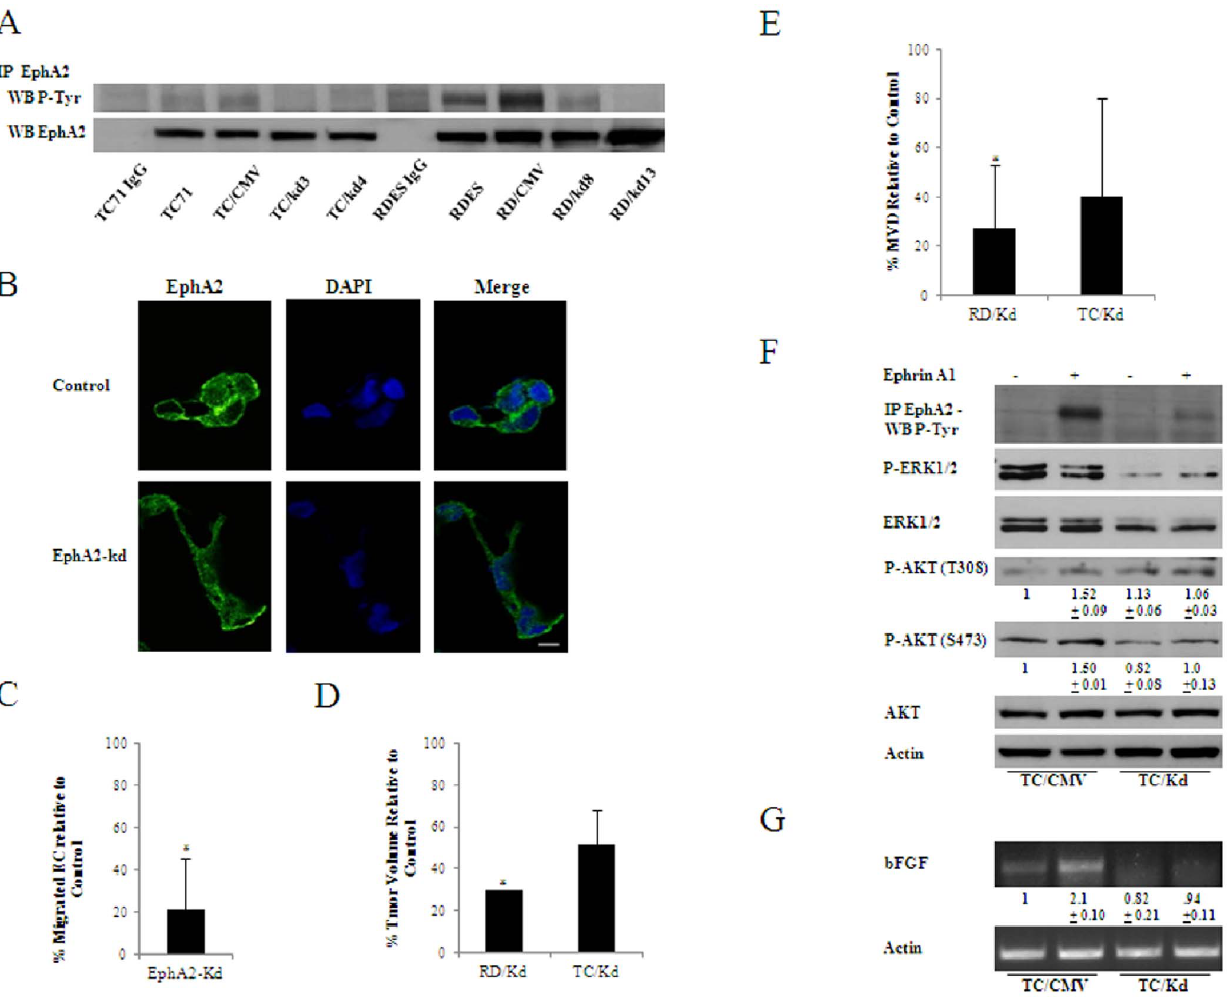
Figure 7. Dominant negative EphA2 recapitulates CAV1 silencing effects on angiogenesis. A. Phosphotyrosine immunoblot confirming the dominant negative effects of EphA2-Kd vector in RDES and TC71 cells (RD/CMV and TC/CMV states for empty-vector transfected cells). EphA2 blotting was used as control. B. Immunofluorescence of EphA2 showing redistribution in cell cytoplasm as a consequence of EphA2-Kd transfection. Scale bar, 10 m m. C. Quantification of transwell cell migration, CM from the EphA2-Kd models was used as chemoattractant for endothelial cells; bars, SD (*P # 0.05 n=3); vertical bars represent mean percentage of migrated endothelial cells relative to control. D. Mice xenograft volumes comparing tumors of 2 EphA2-Kd cell clones (n=5 for each clone) relative to grouped controls (parental n=5; empty vector n=5); vertical bars represent mean percentage of tumor volumes relative to controls; bars, SD (*P # 0.05) E. MVD comparing both EphA2-Kd models and showing a reduction of blood vessels in selected clones relative to controls; bars, SD (*P # 0.05) F. Immunoblot of the TC71 model (Control and EphA2-Kd clone) stimulated with ephrin-A1 showing no changes on the ERK1/2 pathway and activation of AKT. Quantitative data measuring relative intensity of the bands is indicated below each lane for the phospho-AKTs western analysis (n=5) G. RT-PCR showing increased expression of bFGF in control cells compared to EphA2- Kd cells after EphA2 stimulation. Quantitative data measuring relative intensity of the bands is indicated below each lane (n=3).